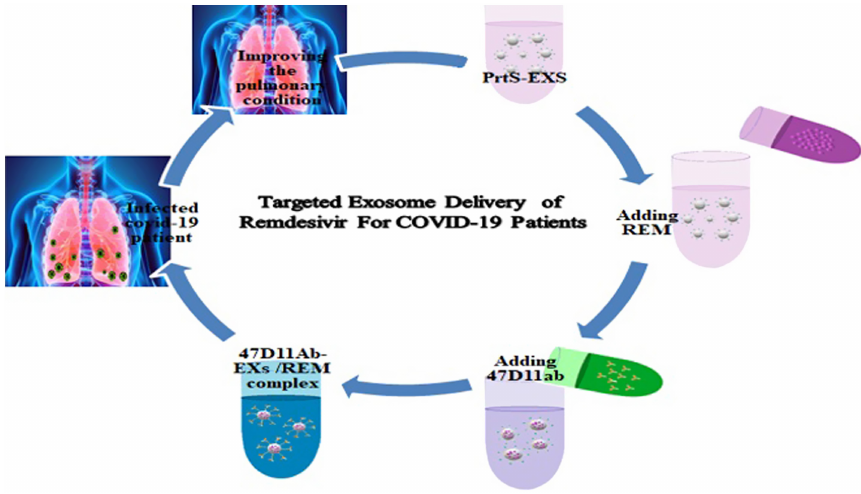
Figure 1. Hypothesis for targeted exosome delivery of remdesivir in COVID-19 patients (created by Esmaeilzadeh et al). PrtS-EXs, exosomes from protein-S-positive mesenchymal stem cells; REM,